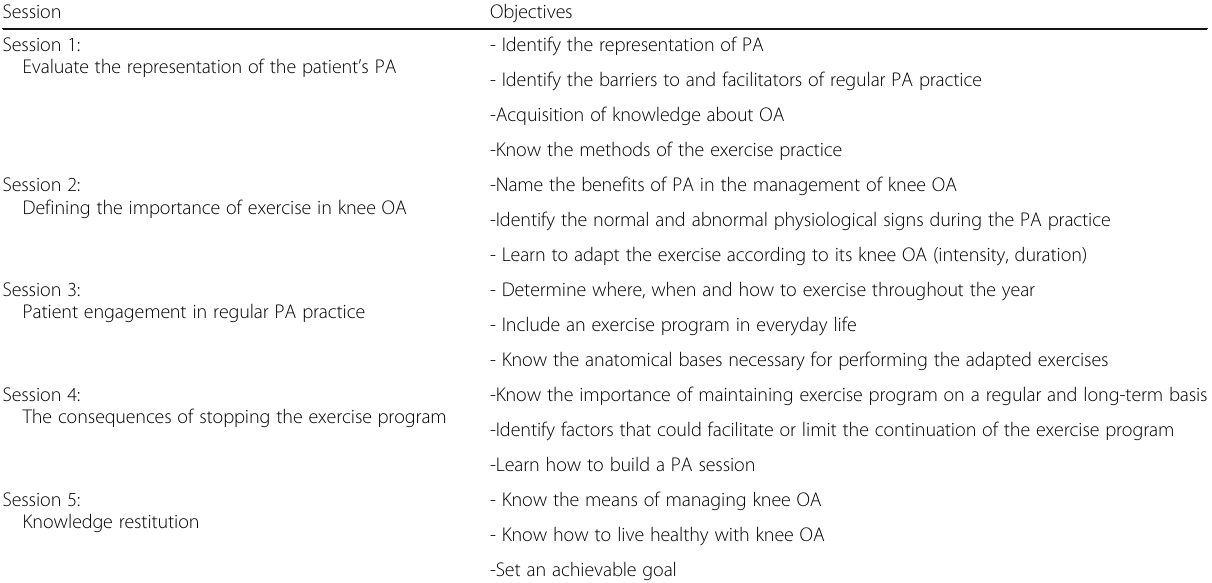
Table 1 Self-management education program Session